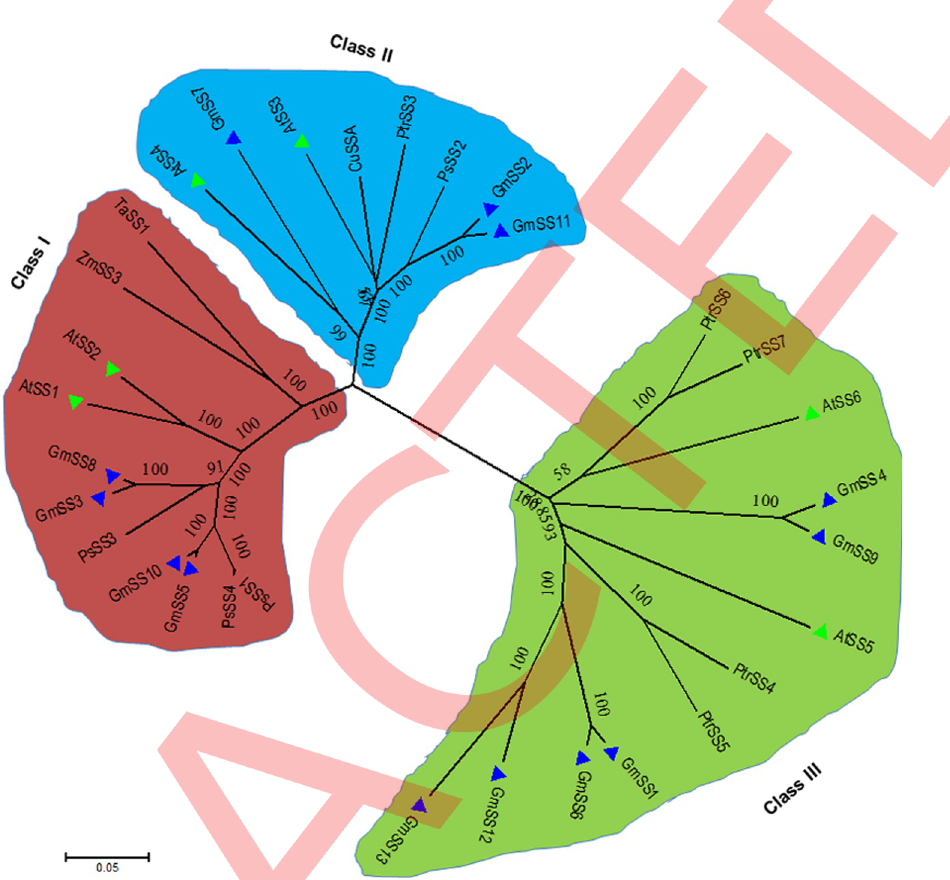
Fig 5. Phylogenetic tree of soybean SS genes with AtSS and other crop plants SS genes. The phylogenetic tree was constructed by MEGA 7.0 using the Neighbour joining method. Bootstrap values in percentage (1000 replicates) are indicated on the nodes. Different classes are highlighted using different colors (Class I in maroon, Class II in blue, and Class III in green).